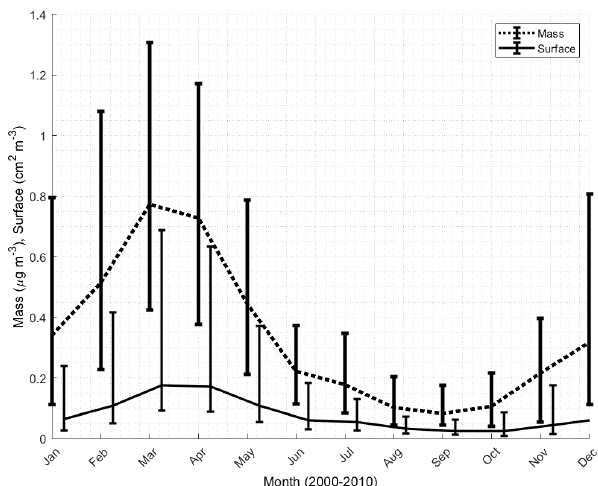
Figure 9. Annual average variation in integrated surface and mass, March 2000 to March 2010. Mass data calculated from the aerosol number size distribution assuming a density of 1gcm − 3 . Error bars show 25th- to 75th-percentile ranges (Tunved et al.,